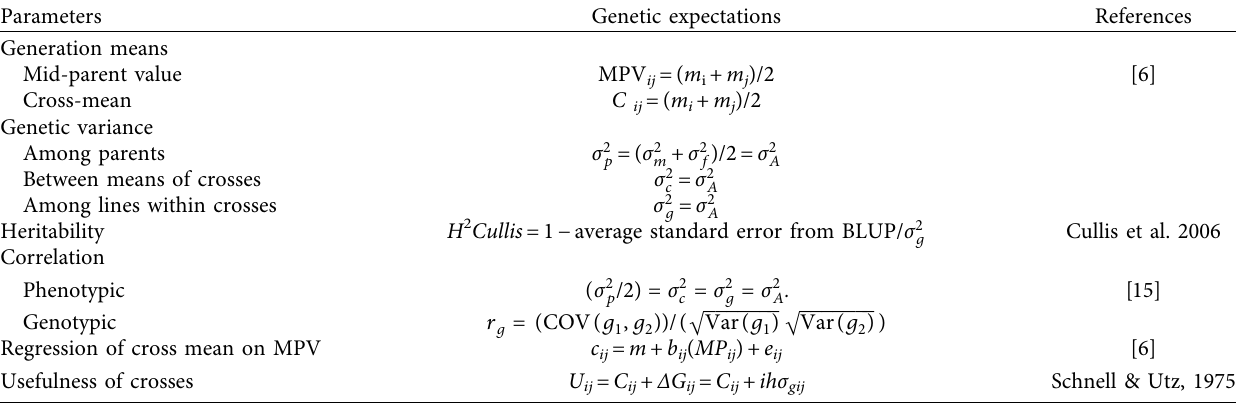
Table 3: Parameter estimation and their quantitative genetic expectation assuming an additive model.